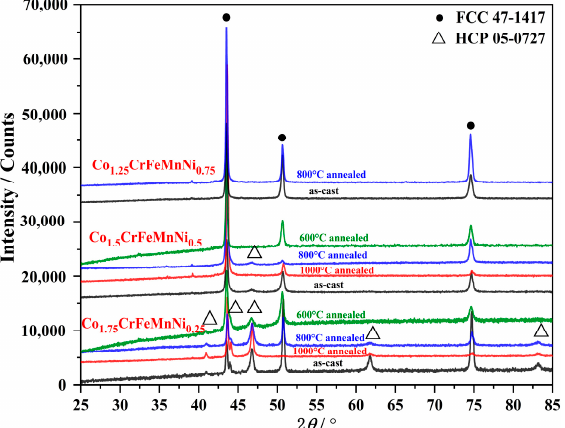
Figure 1. The XRD patterns of the as-cast or annealed Co x CrFeMnNi 2 − x